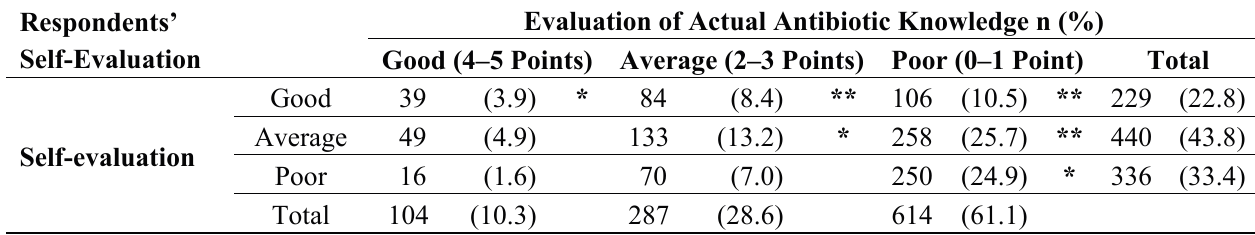
Table 2. Self-evaluation of antibiotic knowledge versus actual knowledge